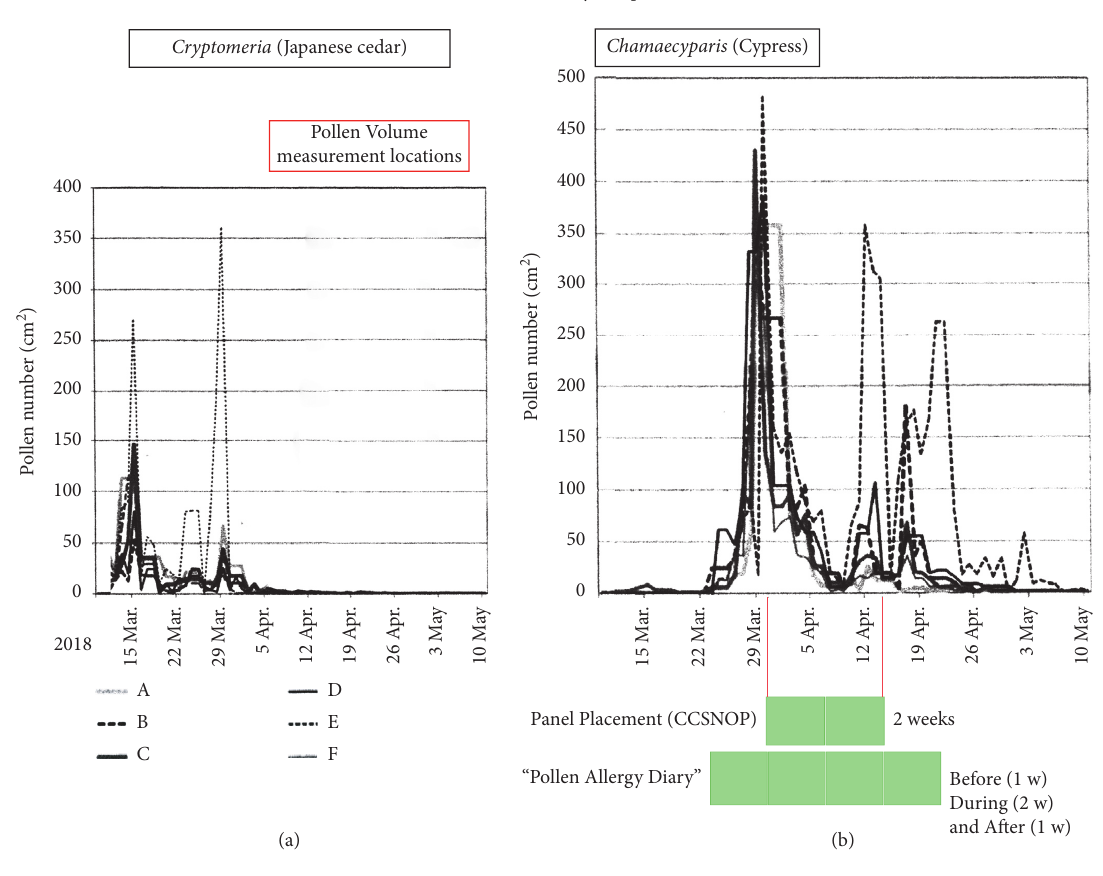
Figure 2: The amount of cypress pollen dispersed from the end of March to the end of April, 2018, in Okayama Prefecture, as obtained from a report by Kimura H (2018). The report is entitled “Cupressaceae (Cryptomeria/Chamaecyparis) pollen dispersal status in Okayama Prefecture.” Ann Rep Chugoku-Shikoku Airborne Pollen Soc. Vol. 29, p2-7, 2018, and is written in Japanese. Panels (a) and (b) show cedar and cypress pollen numbers, respectively, reprinted with permission by the author, Kimura, as well as the Editor-in-Chief, Dr. Fujiki. As shown in panel (a), cedar pollen dispersal ended at the end of March, 2018. On the other hand, as shown in panel (b), cypress pollen dispersal began in the middle of March and continued for more than one month. The lower part of panel (b) shows the periods encompassing CCSNOP panel exposure (2 weeks) and the keeping of a “Symptom Diary” (4 weeks). Although days with lower levels of pollen were observed (due to rain) during the 2-week period of CCSNOP exposure, the approximate average pollen dispersal seemed to be sufficient to evaluate the effects of CCSNOP. One week before panel installation also had sufficient pollen dispersal. However, one week after panel removal, pollen dispersal was relatively low. Only location E showed sufficient pollen dispersal during this period, although the majority of volunteers were not residing close to this